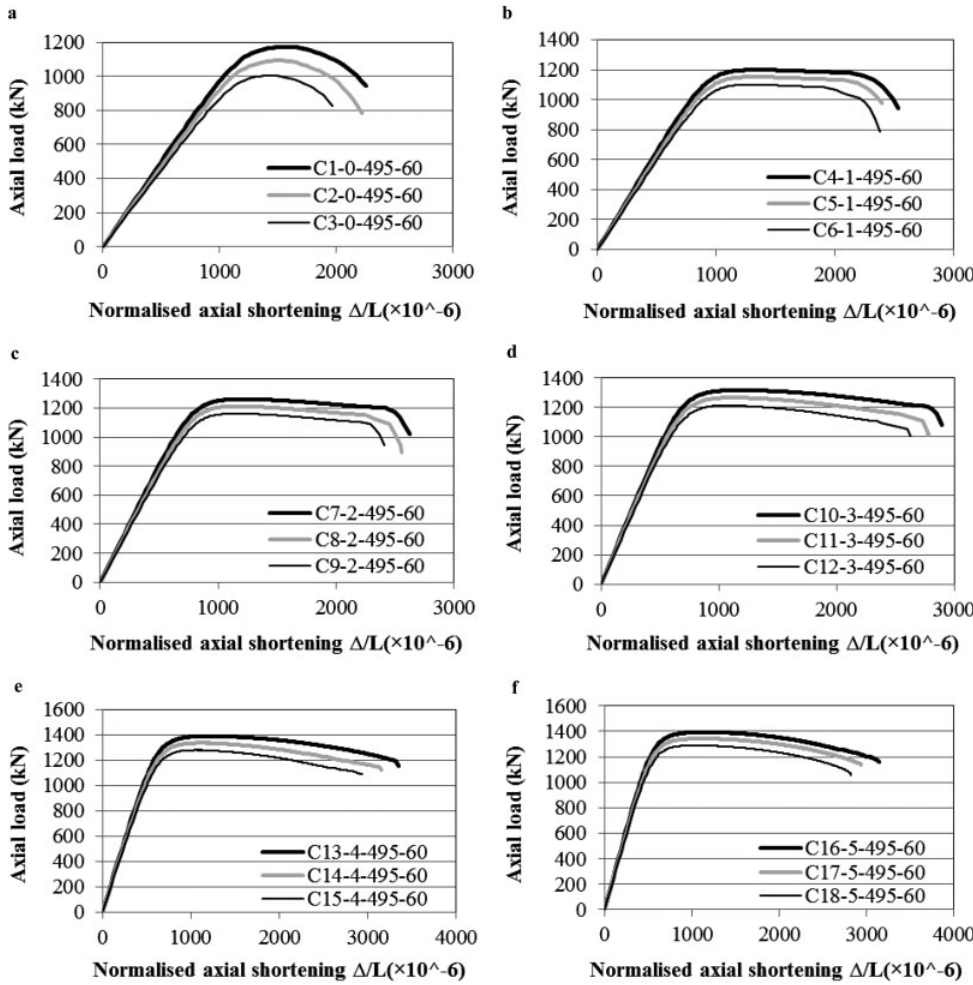
Fig. 6. Axial load-normalised axial shortening curves for the columns: (a) u (cid:4) 0 8 , (b) u (cid:4) 0.55 8 , (c) u (cid:4) 1.10 8 , (d) u (cid:4) 1.65 8 , (e) u (cid:4) 2.20 8 , (f) u (cid:4) 2.75